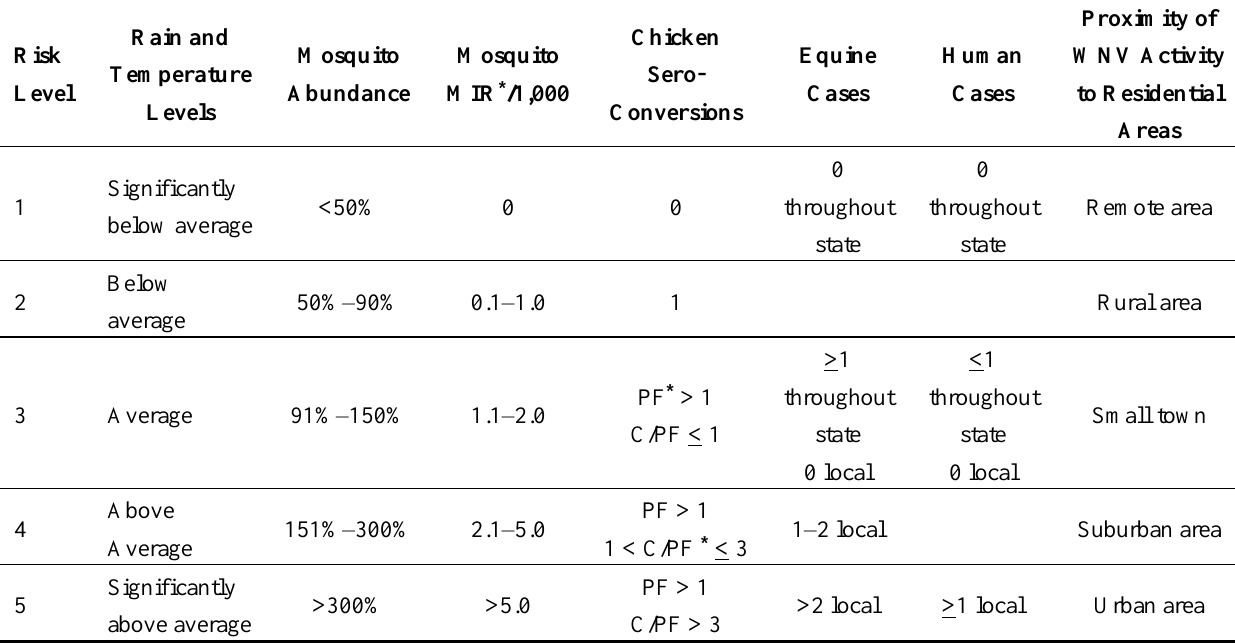
Table 7. Risk factors and thresholds for WNV risk assessment